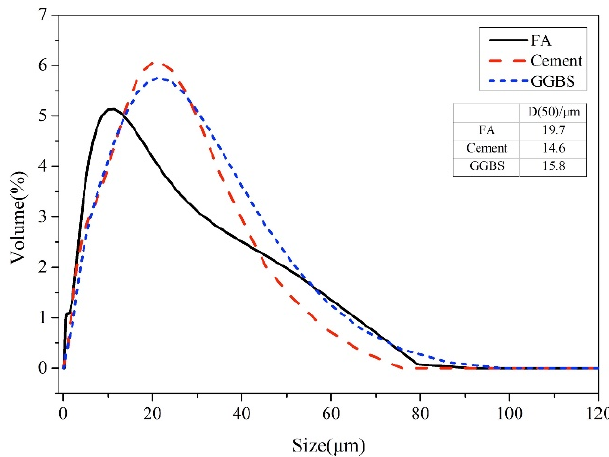
Figure 1. Particle size distribution of fly ash (FA), ground granulated blast furnace slag (GGBS), and cement. Table 1. Chemical compositions of raw materials.